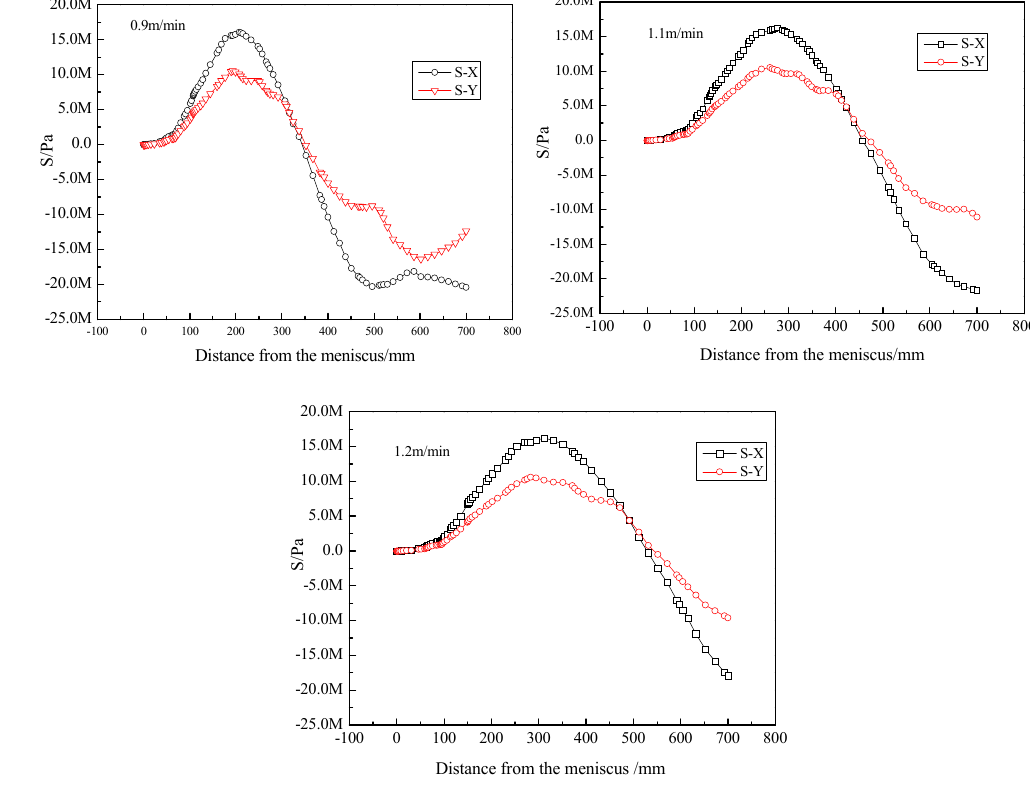
Figure 15. Stress at fillet at different casting speeds.